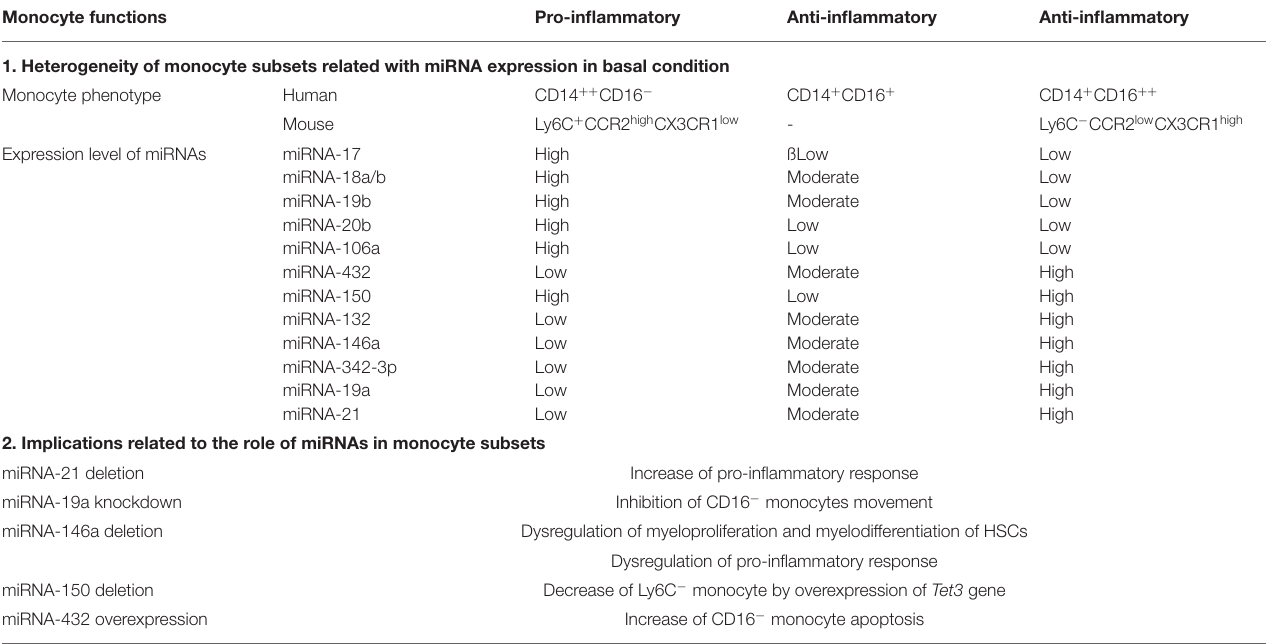
TABLE 1 | miRNAs-related monocyte heterogeneity. Monocyte